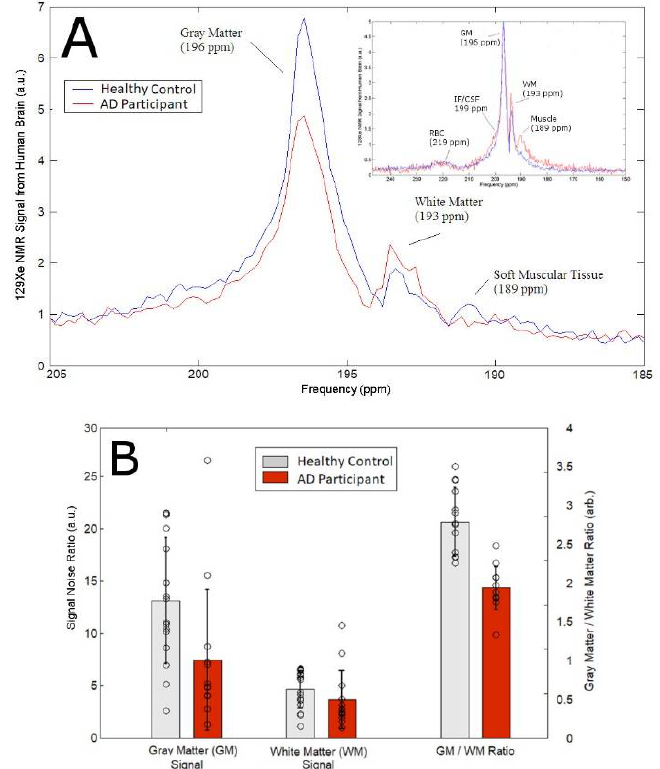
Figure 1. ( A ) Representative 129 Xe MRS of healthy controls and AD participants. ( B ) Signal intensity of GM, WM, and the ratio of GM to WM in healthy controls compared to AD participants. a.u. = arbitrary units.